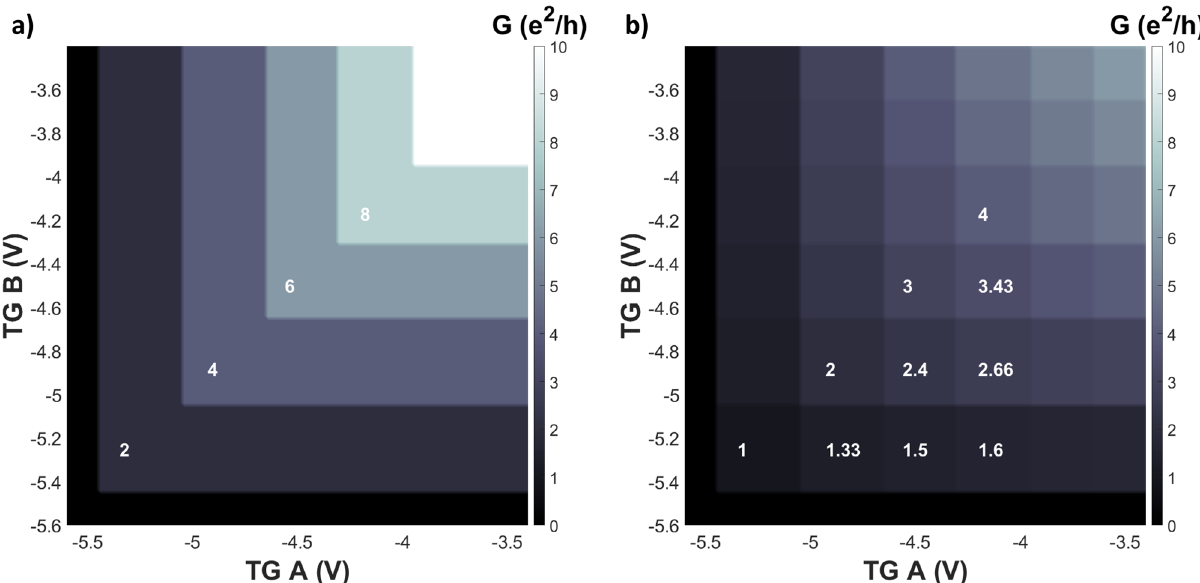
Figure 3. Calculated model of the series resistance of two wires A and B separated by a 2DEG tap, showing a contour plot of conductivity as function of both top-gate voltages. ( a ) Non-invasive tap: no scattering inbetween the wires leading to a ballistic behavior across both wires. ( b ) Invasive tap: the two wires A and B act like two resistances in series where each wire resistance is given by the parallel resistances of its occupied a) depicts a contour plot of conductivity as a function of both top-gates A and B, based on a resistance model of ballistic transport. The top-gate values indicating the onset of a new sub-band have been taken from our measurements. In the ballistic case, with no scattering, the wire with the lower number of modes will define the conductance over both wires. The modeled conductance is thus given by G = min ( G A , G B ) . The modes carrying the current through both wires and the tap, are regarded as in parallel to each other. If the 2DEG tap between the two wires is invasive, meaning the electrons scatter into 2DEG modes after pass- ing wire A, the system is in diffusive transport regime. The plot of Fig. 3b) depicts a contour plot based on the resistance model for diffusive transport, showing a typical check-board pattern. Here due to the invasiveness of